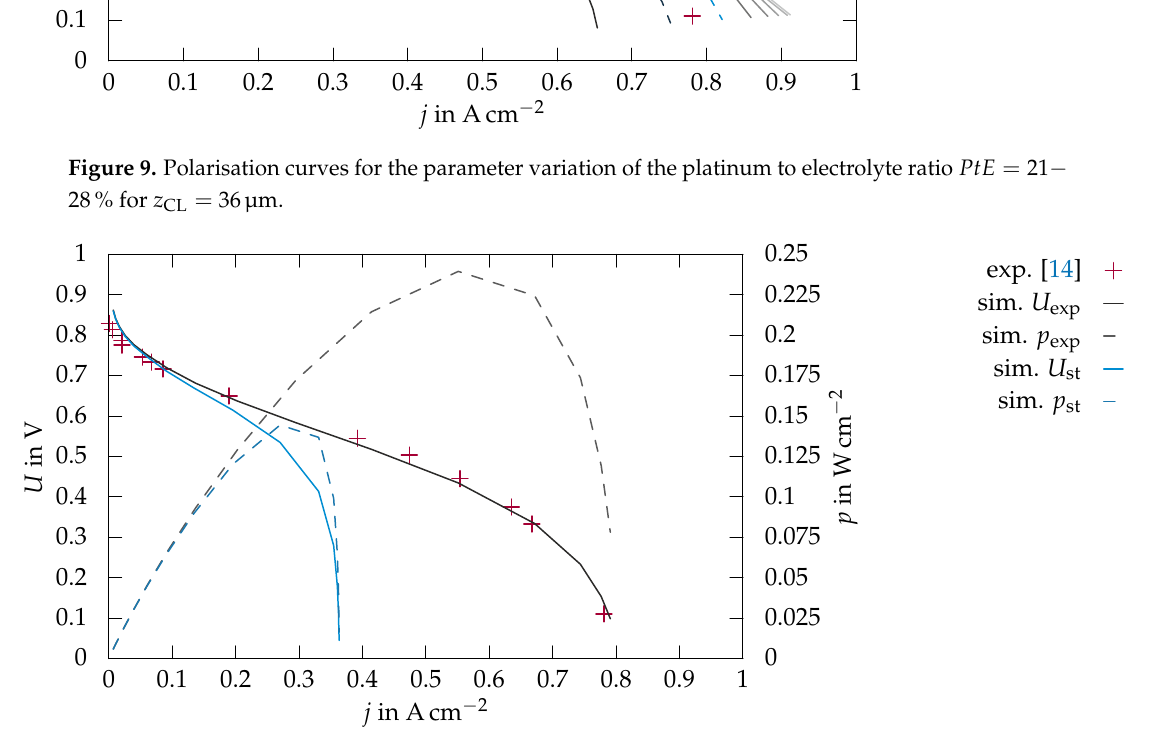
Figure 10. Polarisation (solid) and power density (dashed) curves for the cell with z CL = 36µm and PtE = 26.5% under the experimental flow conditions (grey) and stoichiometric flow conditions